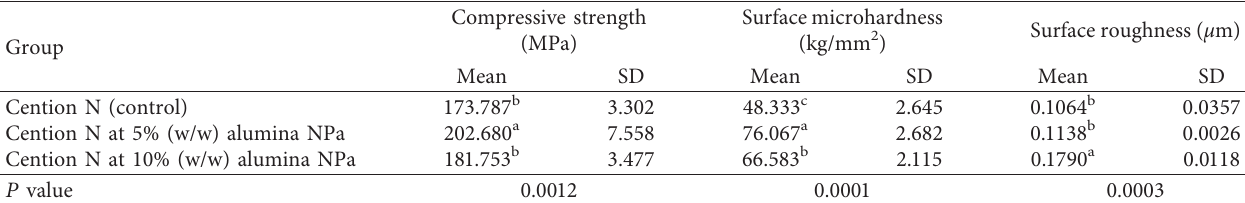
Table 1: Means and standard deviations (SD) of physical properties of Cention N with alumina NPs incorporation and Tukey’s analysis.